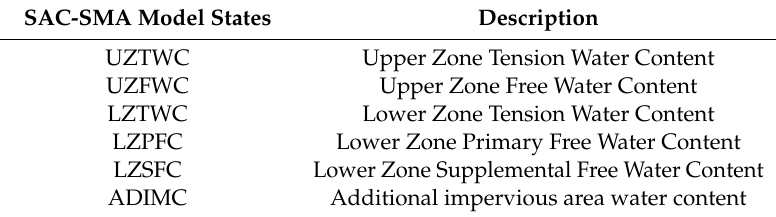
Table 1. Model states updated via MVAR and VAR for the distributed SAC-SMA